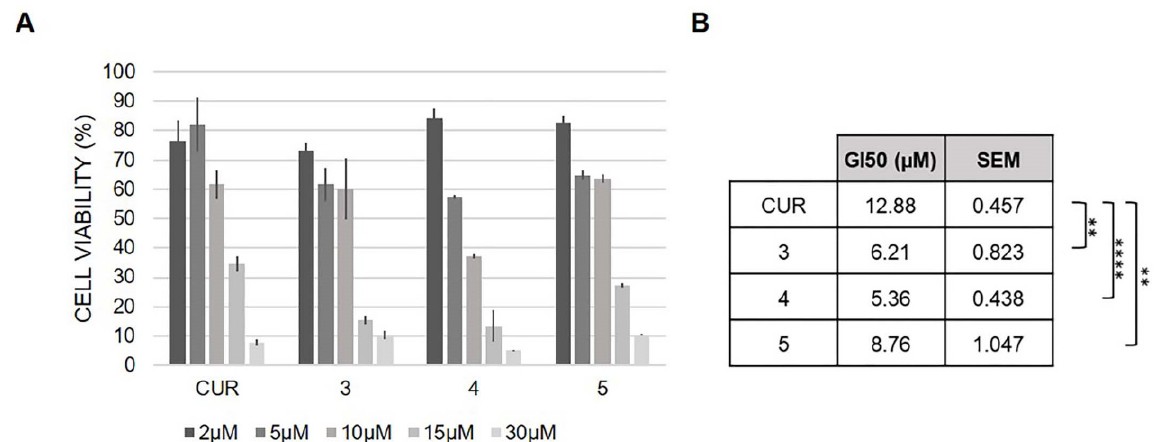
Figure 12. Biological activity of the selected curcumin derivatives on human colorectal HCT116 cancer cells. Panel ( A ): dose-dependent effect of curcumin derivatives administration for 48 h on the cell growth of HCT116 cancer cells as assessed by the MTT assay. Panel ( B ): GI 50 values and statistical significance compared to curcumin are indicated as the means ± SEM (unpaired t -test: ** p < 0.01, **** p < 0.0001).